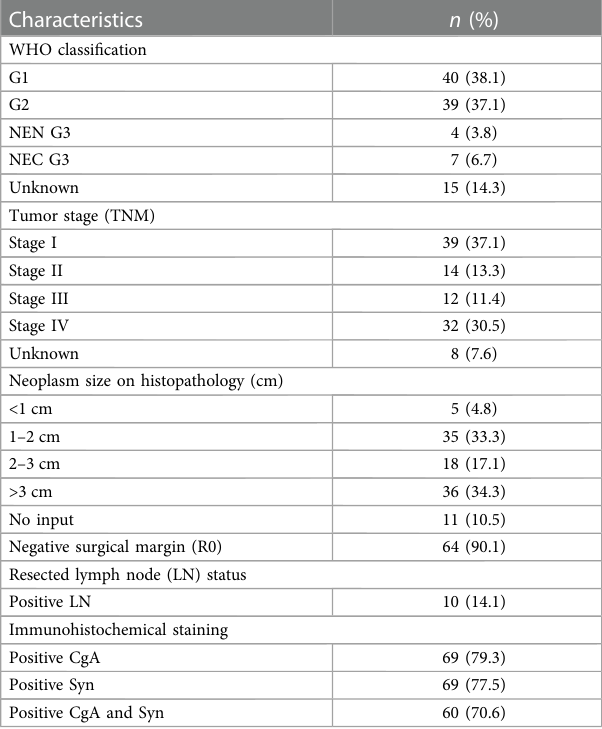
TABLE 3 Pathological characteristics of PNEN. Characteristics